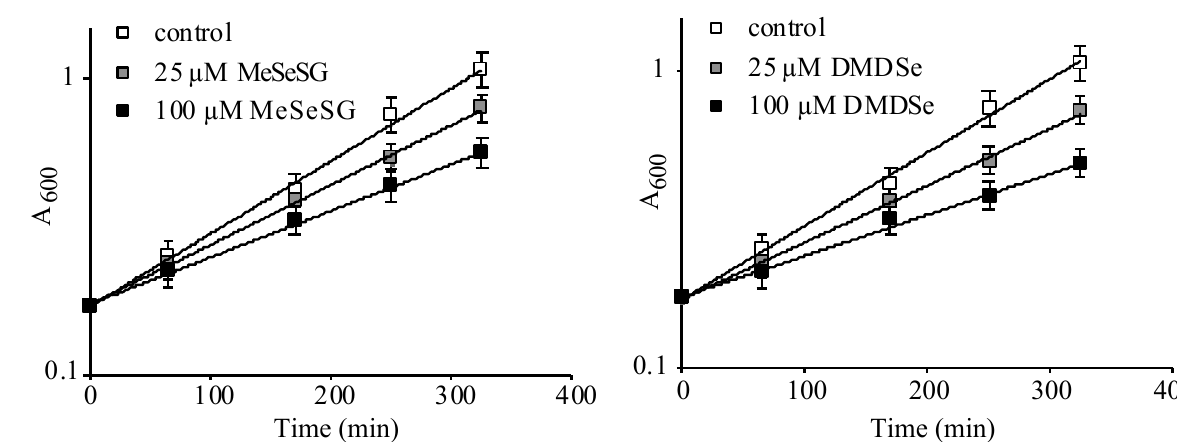
Figure 1. Cell growth inhibition by methylselenol (MeSeH) precursors. Exponentially growing BY4741 cells in SC medium supplemented with 100 µM methionine were diluted to 0.1 OD 600 in the same medium and left to grow for 2 h. At time zero, 0 ( ), 25 ( ) or 100 µM ( ) of methylselenoglutathione (MeSeSG) ( left panel ) or dimethyldiselenide (DMDSe) ( right panel ) were added and cell growth was monitored by measuring the OD 600 at various times during 6 h. Data were plotted on a semi-log scale as a function of time. Doubling times of 119 ± 14 (control), 147 ± 16 (25 µM MeSeSG), 192 ± 19 (100 µM MeSeSG), 157 ± 16 (25 µM DMDSe) and 223 ± 24 (100 µM DMDSe) min were calculated by using regression analysis. The results are the mean and range of two experiments.